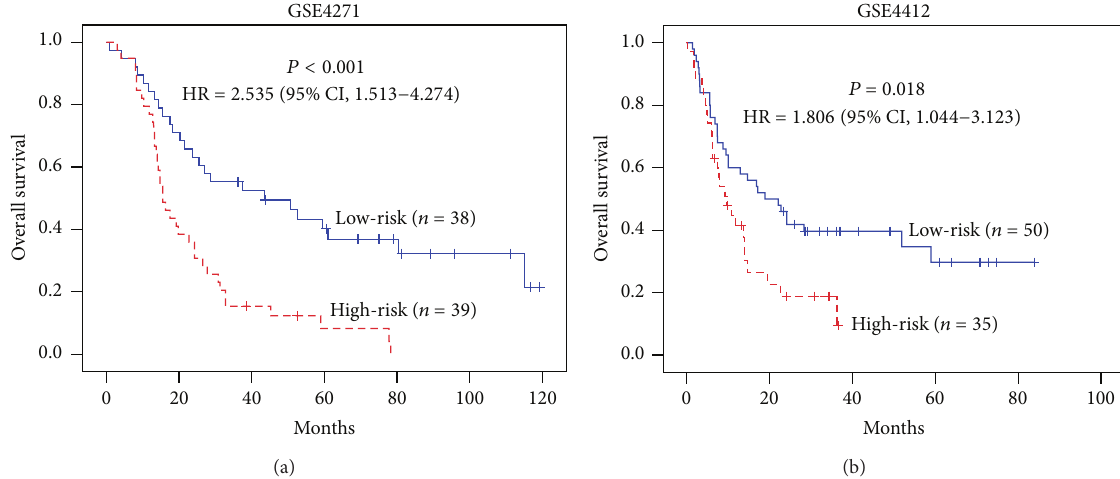
Figure 4: Survival curves of the glioma patients. Abbreviations: HR—hazard ratio; CI—confidence interval. The Cox regression model was trained with the 26 genes refined by the GSE4271 training dataset. The median of the estimated risk scores was used as the cutoff to divide the patients into high-risk and low-risk groups. 𝑃 values were obtained from the log-rank test.